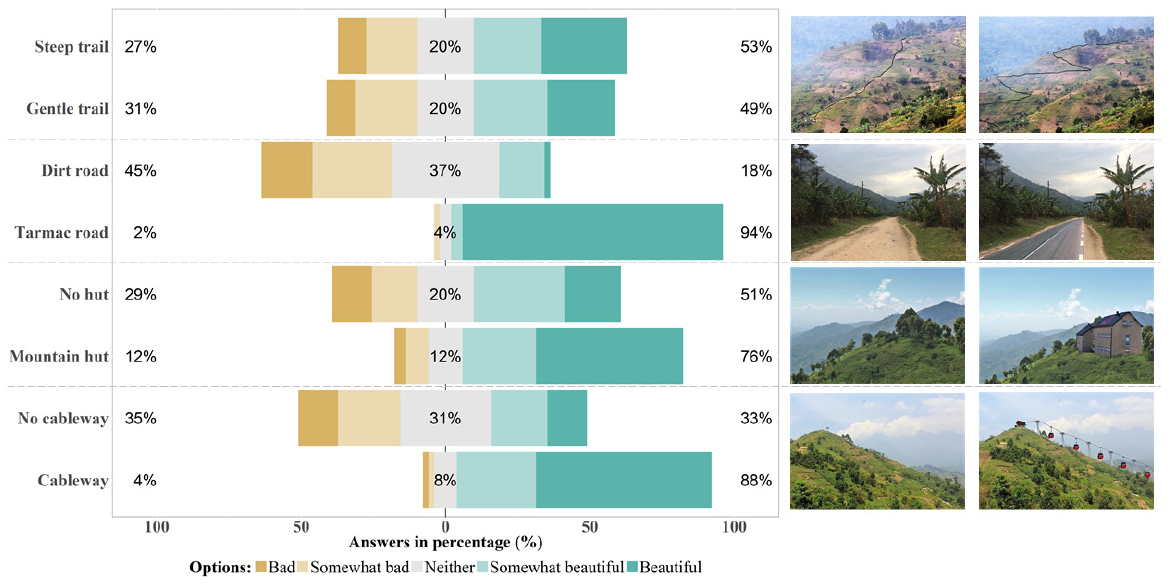
Figure 5. Comparison of engineered facilities favouring tourism using photo surveys: assessment of respondents’ preferences. respondents’ preferences.